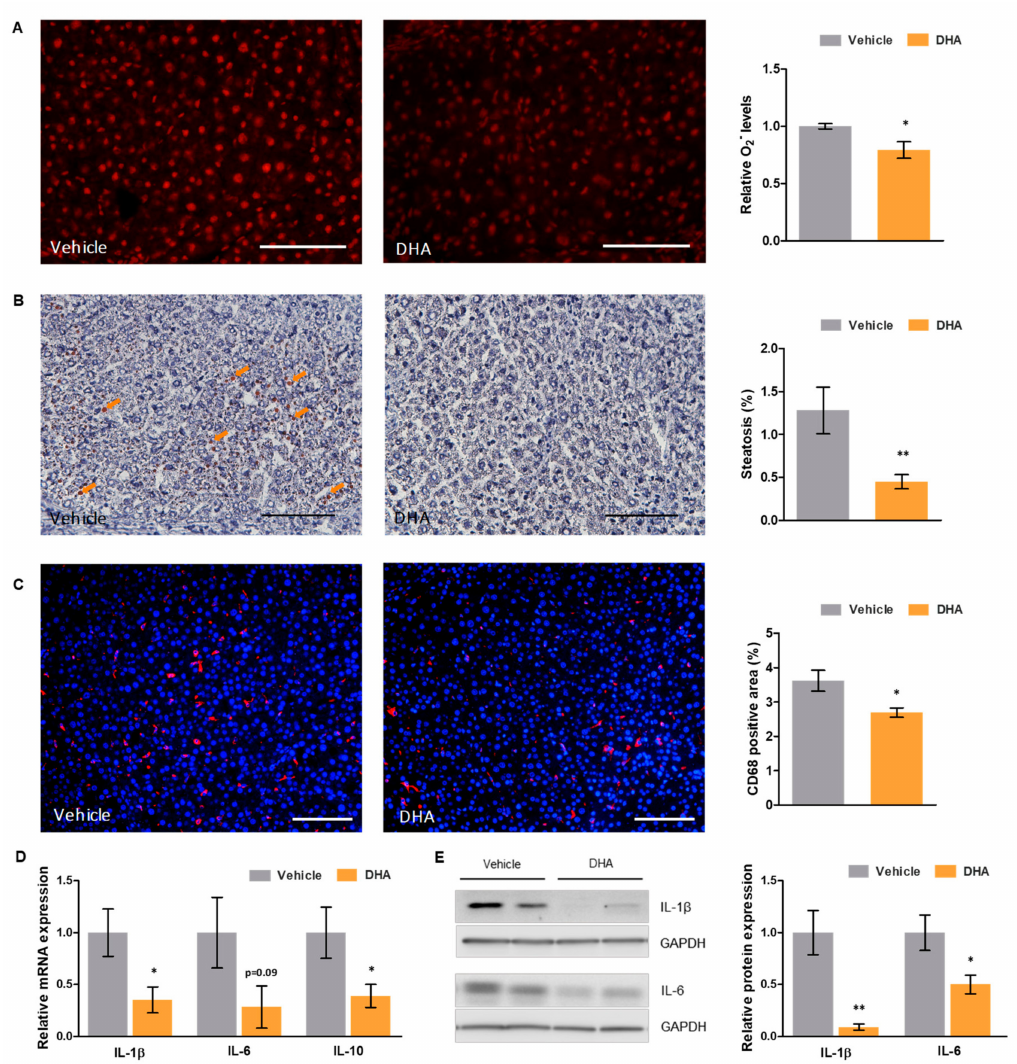
Figure 1. E ff ects of DHA on oxidative stress and inflammation in a rat model of ACLD. ( A ) Representative images of dihydroethidium staining in liver tissue sections from cirrhotic rats treated with DHA or vehicle (left—scale bar represents 200 µ m), and corresponding quantification of superoxide (O 2 − ) levels (right). ( B ) Representative images of oil red O staining of liver tissue cryosections from cirrhotic rats treated with DHA or vehicle (left—scale bar represents 100 µ m), and corresponding quantification (right). ( C ) Representative images of CD68 immunofluorescence in liver tissue sections from cirrhotic rats treated with DHA or vehicle (left—scale bar represents 200 µ m; CD68 positive cells in red and nuclei in blue), and corresponding quantification (right). ( D ) Relative mRNA and ( E ) protein expression of key interleukins in total liver tissue from cirrhotic rats treated with DHA or vehicle, normalized to GAPDH. Results are expressed as mean ± S.E.M. * p < 0.05 and ** p < 0.01 vs. vehicle. n = 3 per group ( A ), n = 11 per group ( B , C ), and n = 10 per group ( D , E